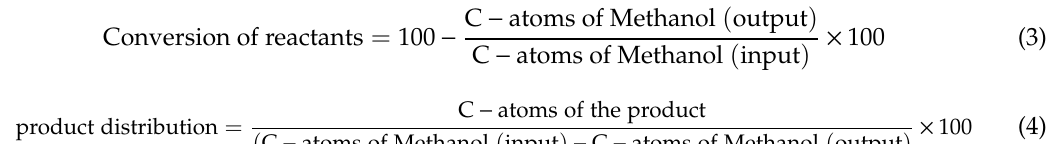
Figure S1: Physicochemical properties of used as parent zeolite for the synthesis of CHA, Figure S2: XRD patterns of products, Figure S3: 27 Al MAS NMR spectra of the calcined Na + -type products, Figure S4: 27 Al MAS NMR spectra of the H + -type products, Table S1: The products’ selectivities in the MTO reaction over